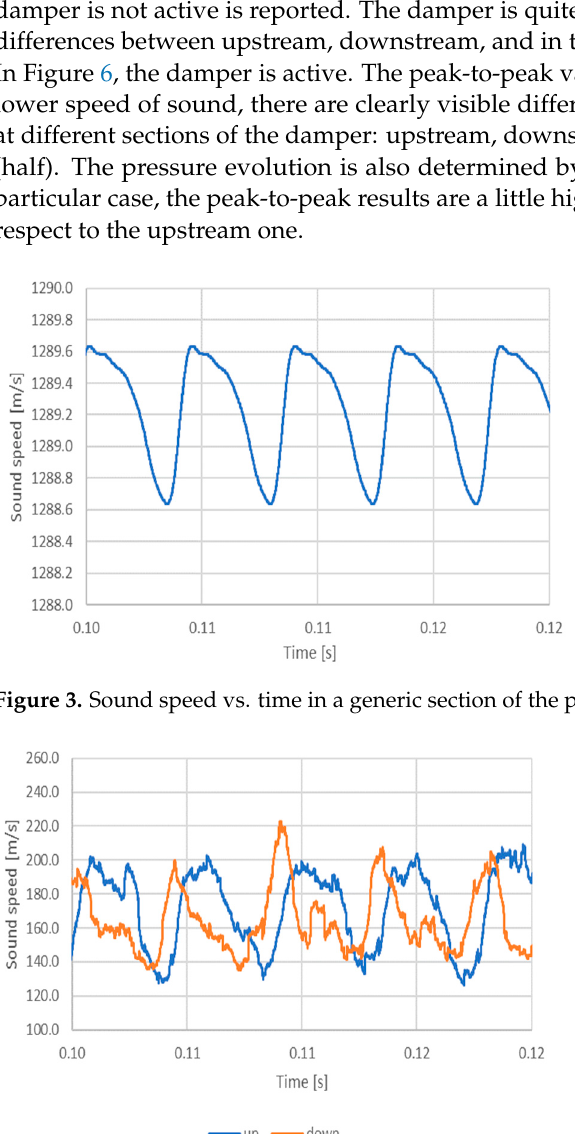
Figure 4. Sound speed in upstream and downstream section, damper active.